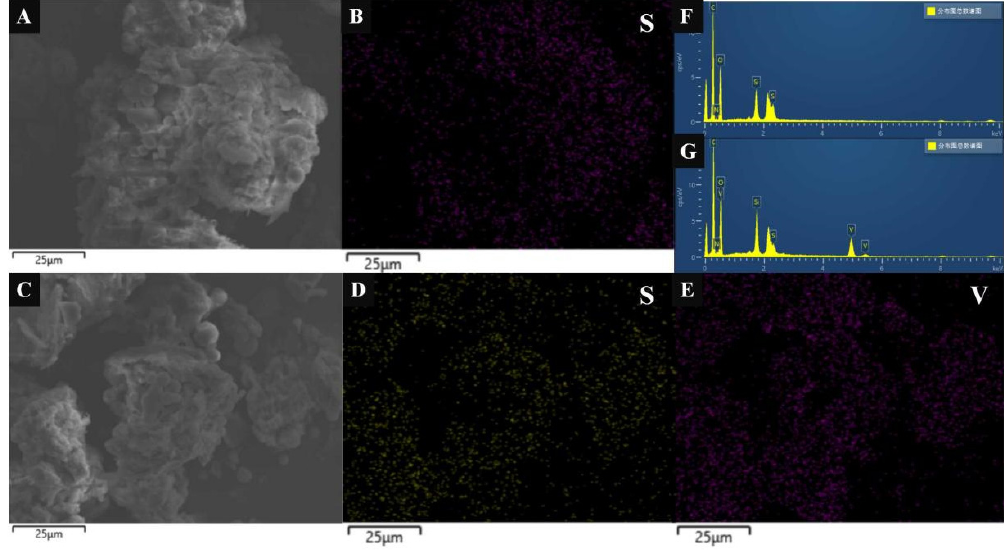
Figure 8. SEM − EDS images of CS 2 C@SBA − 3 before adsorption with V(V) ( A ) and EDS elemental mapping images ( B , F ), SEM − EDS images of CS 2 C@SBA − 3 after adsorption with V(V) ( C ) and EDS elemental mapping images ( D , E , G ). Conditions: Conditions: V(V) initial concentration = 100 ppm,